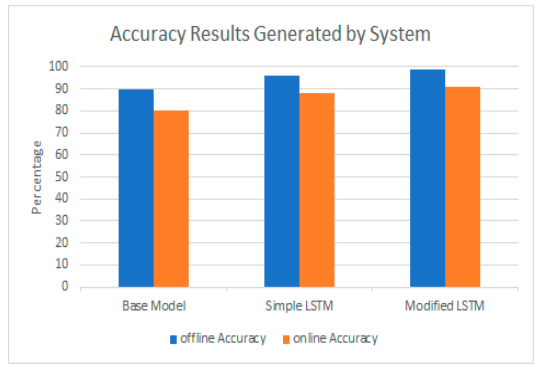
ffl ine vs. online accuracy of forecasting. Figure 12. Offline vs. online accuracy of forecasting. Figure 12. O